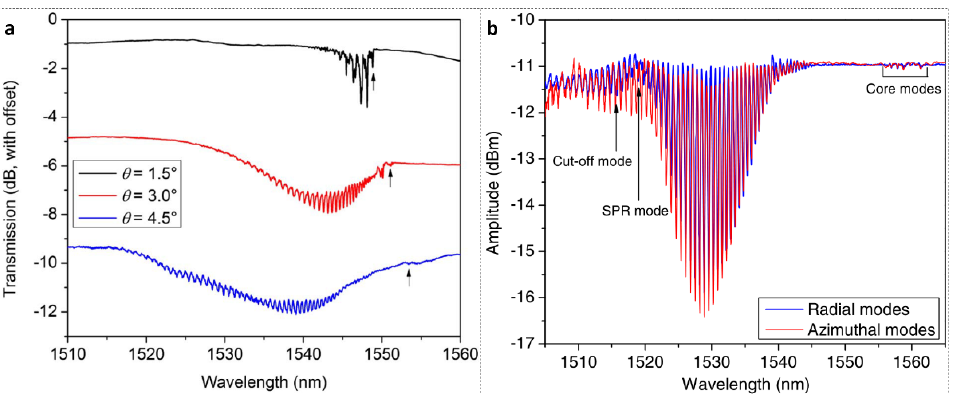
Figure 14. ( a ) Transmitted amplitude spectra of 6-mm-long TFBGs photo-inscribed at different tilt angles in slightly etched TS-doped POF. Reprinted with permission from [37]. ( b ) The transmitted amplitude spectra of 6 ◦ TFBG-SPR immersed in a solution with refractive index 1.408 in orthogonal polarizations. Reprinted with permission from [72].